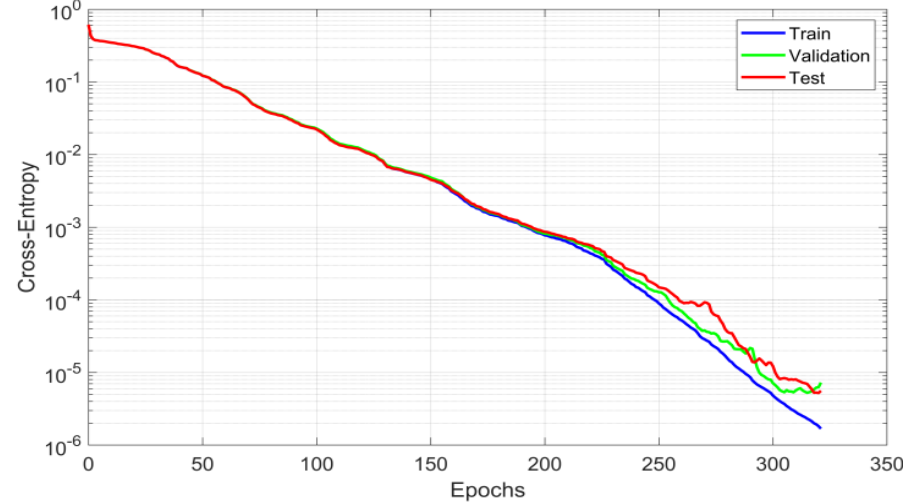
Figure 8. Cross-entropy loss results over epochs.